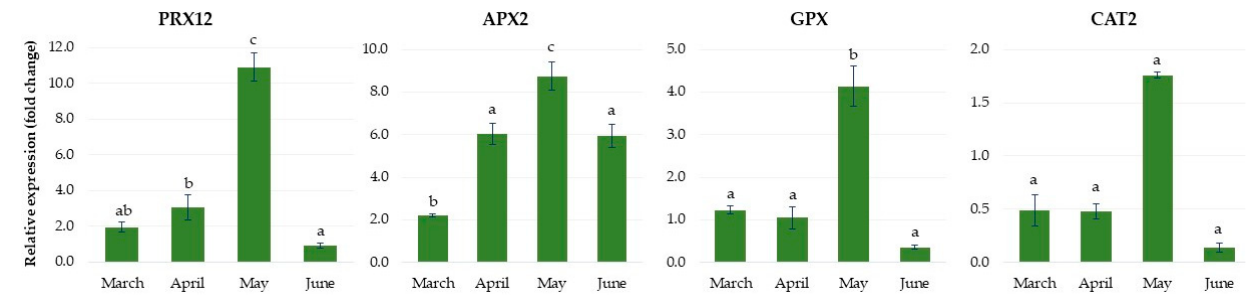
Figure 14. The relative expression of the genes involved in antioxidant metabolism in rhubarb ‘Raspberry’ plantlets during ex vitro growth in the greenhouse from early March to the end of June. According to Duncan’s test ( p = 0.05), means marked with the same letter do not differ significantly ( p = 0.05). Error bars represent standard deviation.